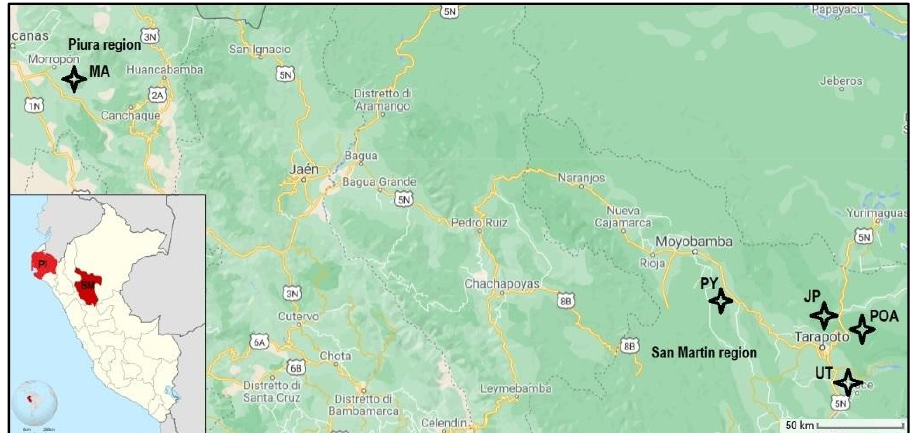
Figure 1. Location of the 5 sampling sites in northern Peruvian regions of San Martin (PY =